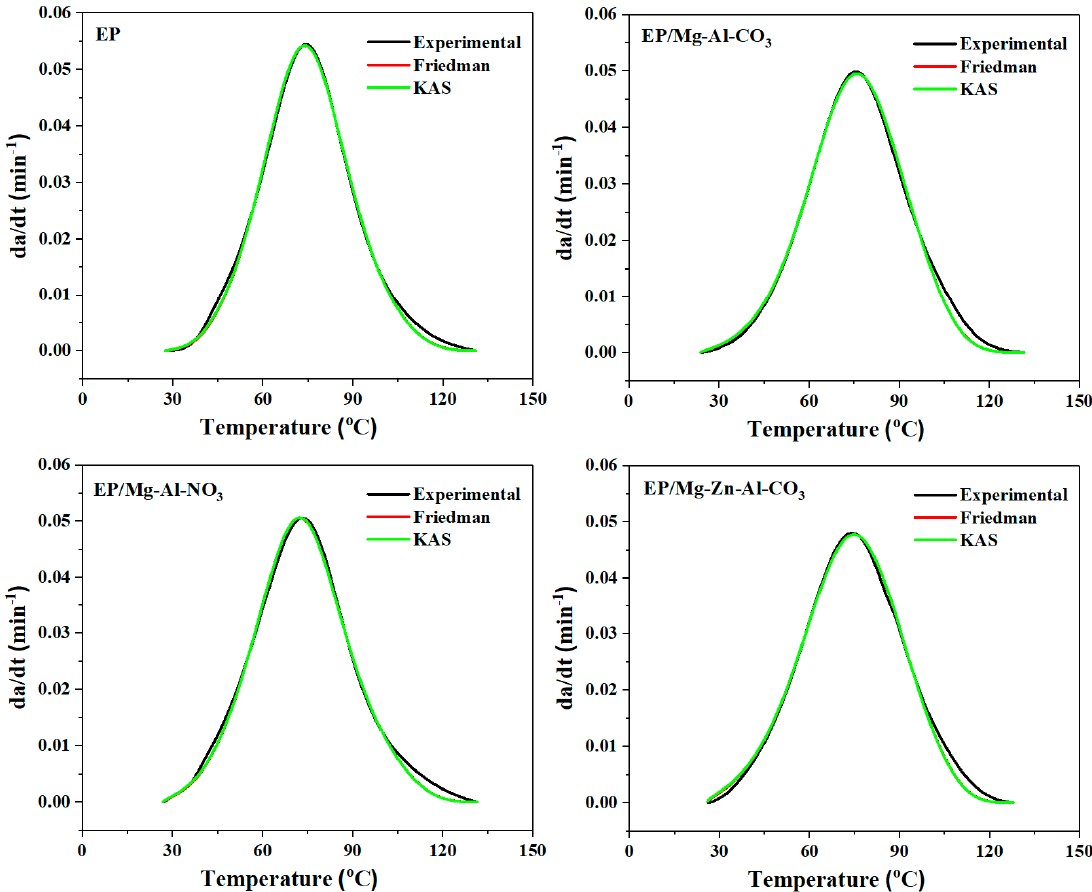
Figure 5. Comparison of experimental data with the kinetic models ( Friedman and KAS ) for prepared samples at a heating rate of 2 °C ∙ min − 1 .